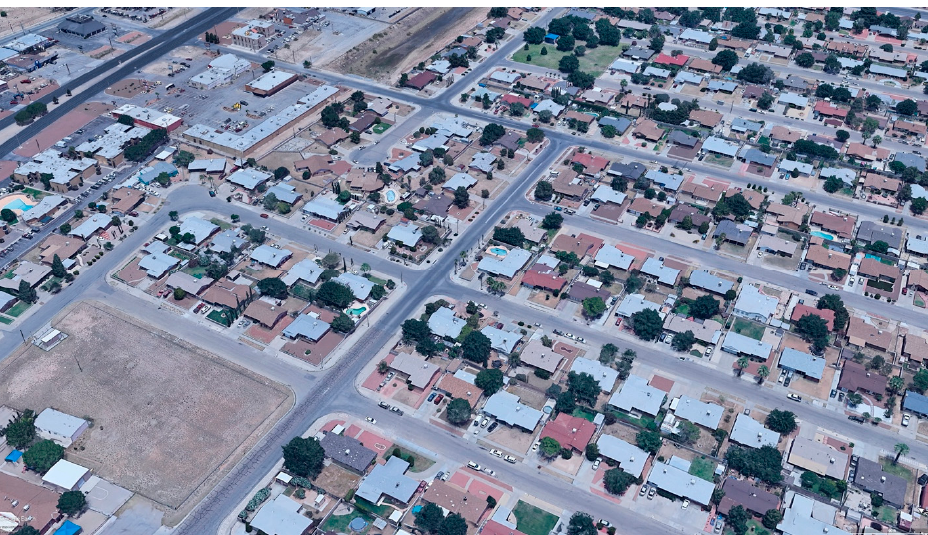
Figure 1. Aerial image showing examples of brownness, greenness, and grayness in a residential area of El Paso, Texas, in June, 2019. Image source: GoogleEarth ® , © 2020 Google; © 2020 INEGI. Here, greenness references NDVI values that range from 0 (no green) to 1 (maximum green). Impervious (“grayness”) represents the percentage of concrete, buildings,